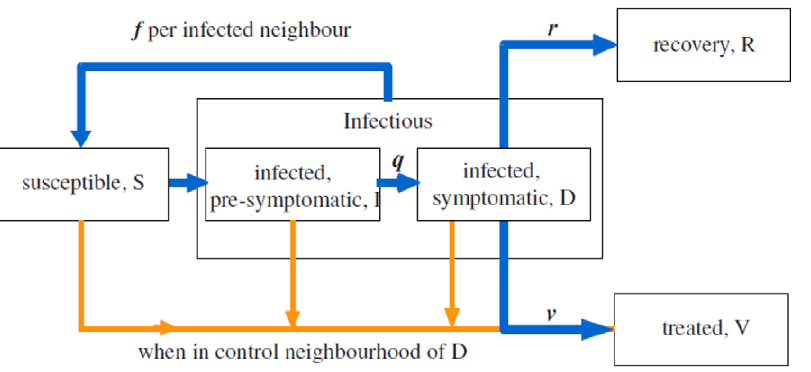
Figure 1. Block diagram illustrating transitions in the model: transitions performed at each time step (blue solid lines) and transitions triggered by treatment (orange thin lines).